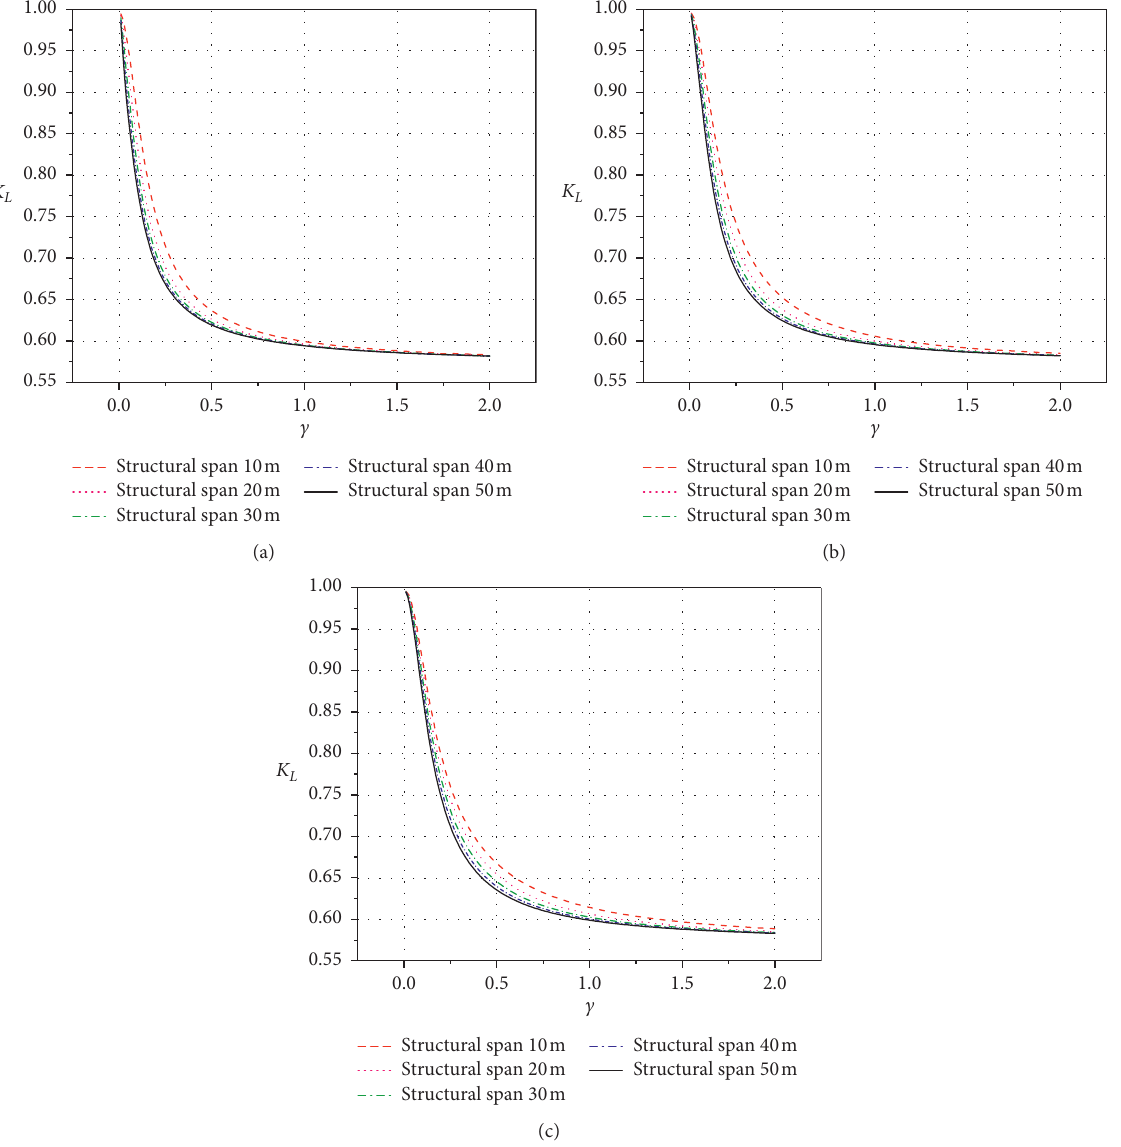
Figure 8: Equivalent load transformation factors of simply-fixed one-way members using Mills’ formula parameters: (a) W � 1kg. (b) W � 10kg. (c) W �